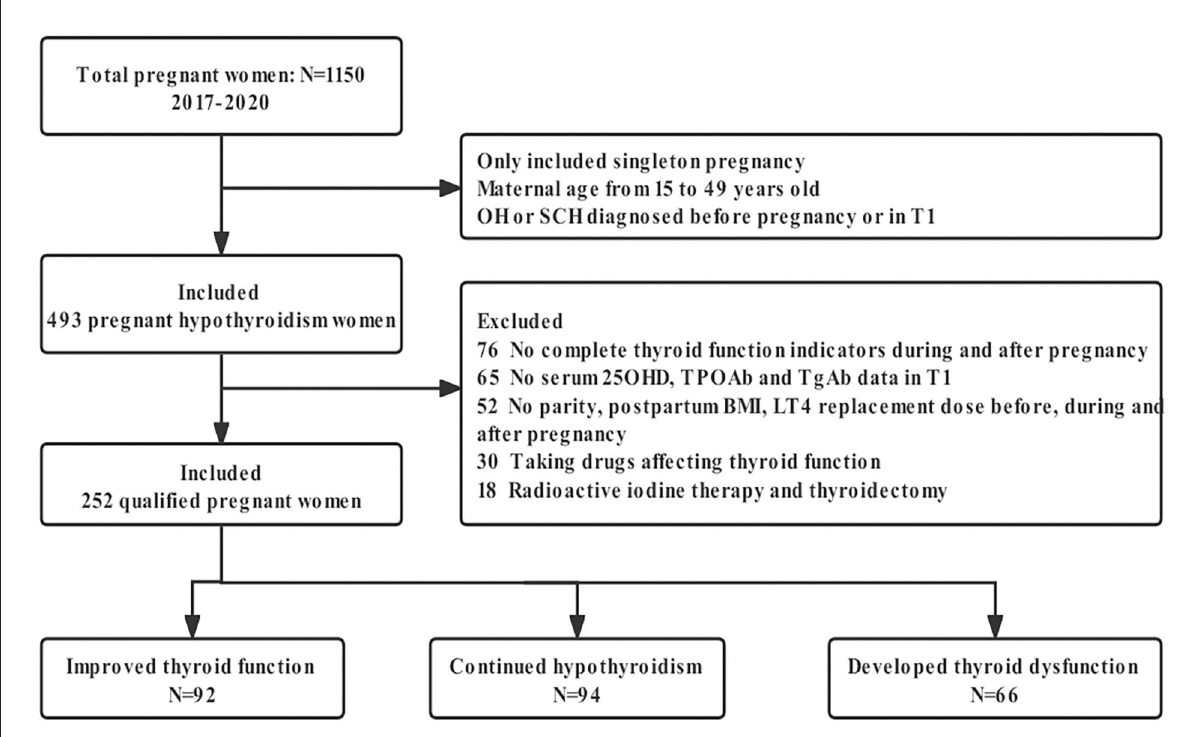
FIGURE1 Flowchart of this study. OH, overt hypothyroidism; SCH, subclinical hypothyroidism; T1, the first trimester of pregnancy; 25OHD, 25-hydroxyvitamin D; TPOAb, thyroid peroxidase antibody; TgAb, thyroglobulin antibody; BMI, body mass index; LT4, levothyroxine.